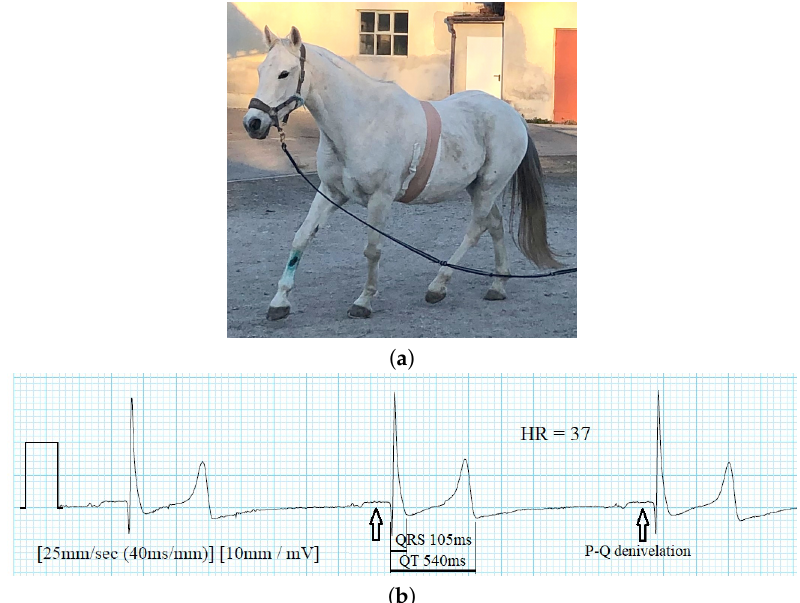
Figure 13. Wireless ECG body sensor used for monitoring in horses. ( a ) Arrab/Lipizanner during exercise. The ECG sensor was bandaged to the thorax to prevent electrode detachment. ( b ) ECG of an adult horse. Note the high amplitude of the QRS compex (2.2 mV) and a typical heart rate while the horse is standing (37